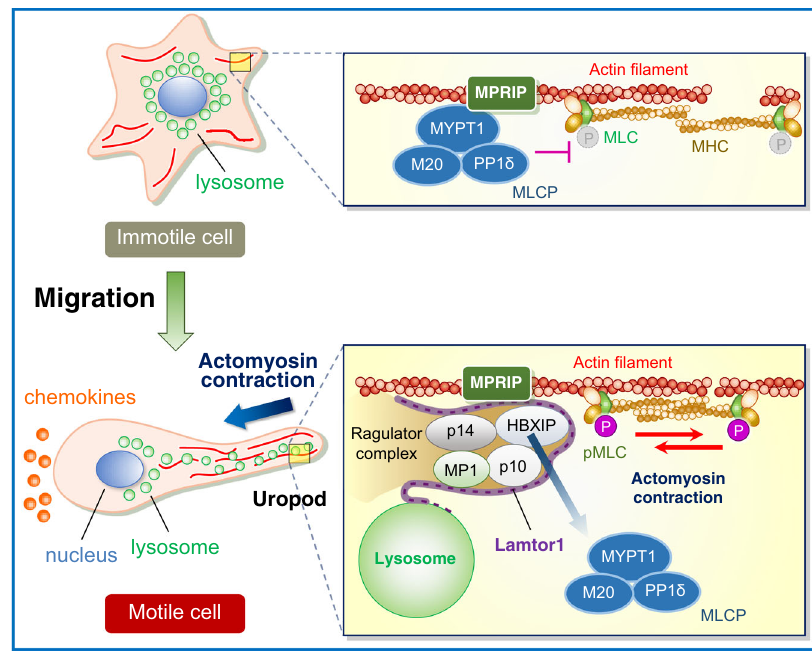
Fig. 10 Schematic of the mechanism of regulation of myosin II activity by the Ragulator complex. In immotile cells (upper), the Ragulator complex localized to lysosomes is preferentially distributed in the perinuclear region (left), and MPRIP anchors MLCP on myosin – actin bundles by binding MYPT1, a subunit of MLCP, resulting in suppression of MLC phosphorylation (right). In motile cells exposed to chemokines (lower), the lysosomes bearing the Ragulator complex moves to the uropod (left), where the Ragulator complex interacts with MPRIP. This interaction interferes with the interaction between MPRIP and MYPT1 and decreases MLCP activity, thereby increasing MLC phosphorylation. Consequently, cell motility is facilitated